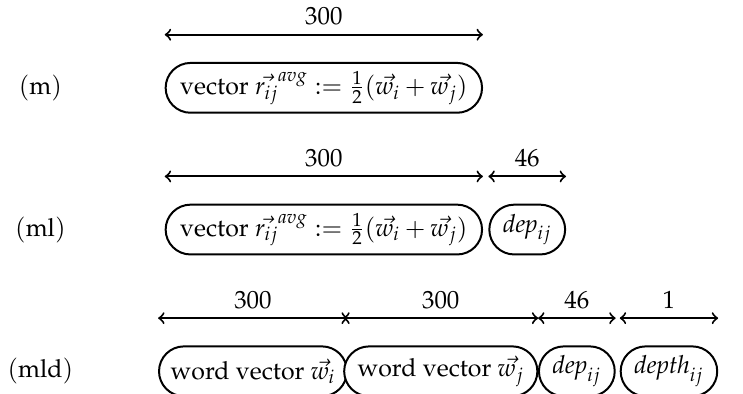
Figure 1. Dependency representation for input configurations (m), (ml) and